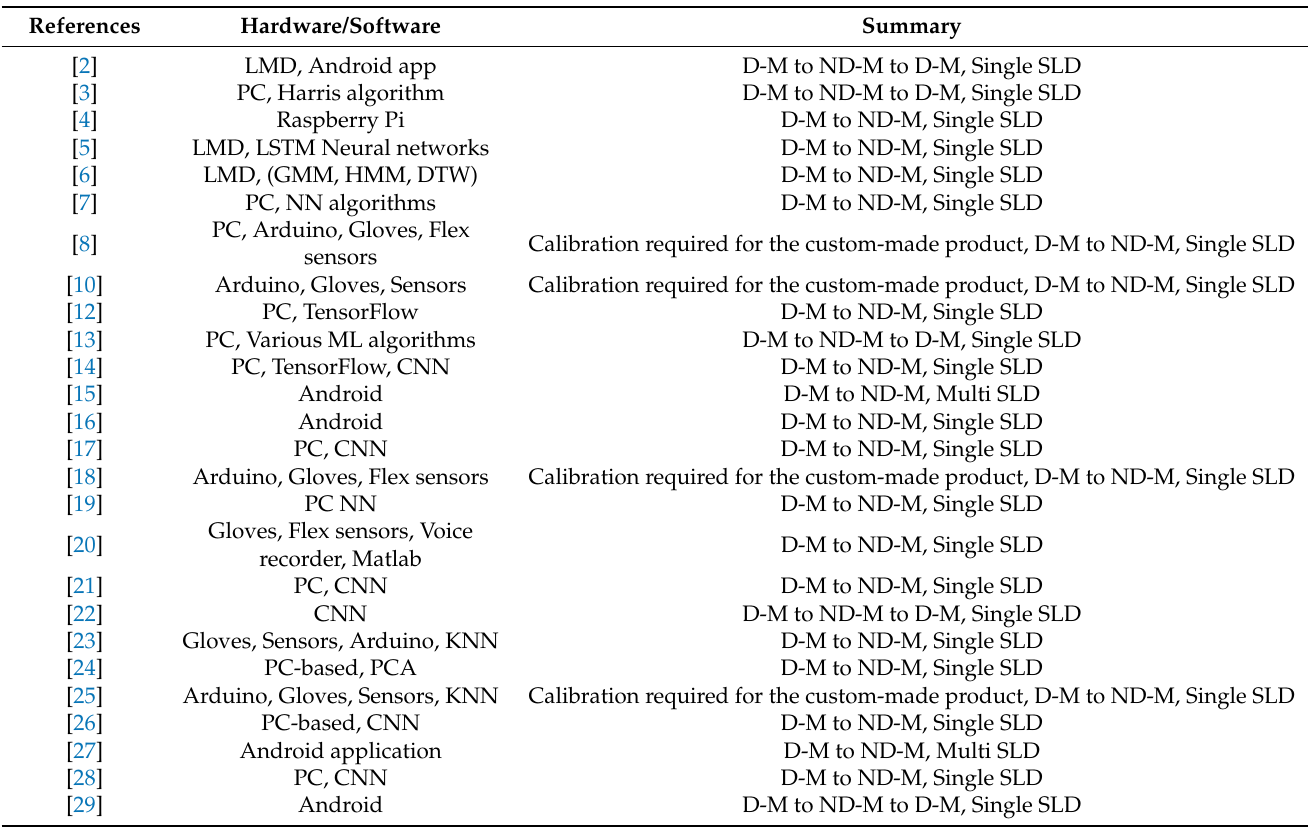
Table 1. Summary of related work